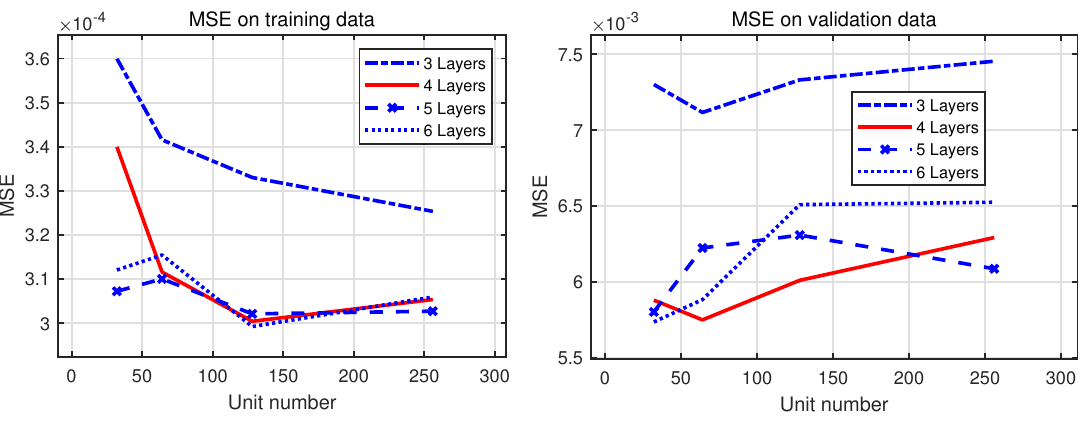
Figure 5. Loss comparisons of DNN with different sizes.